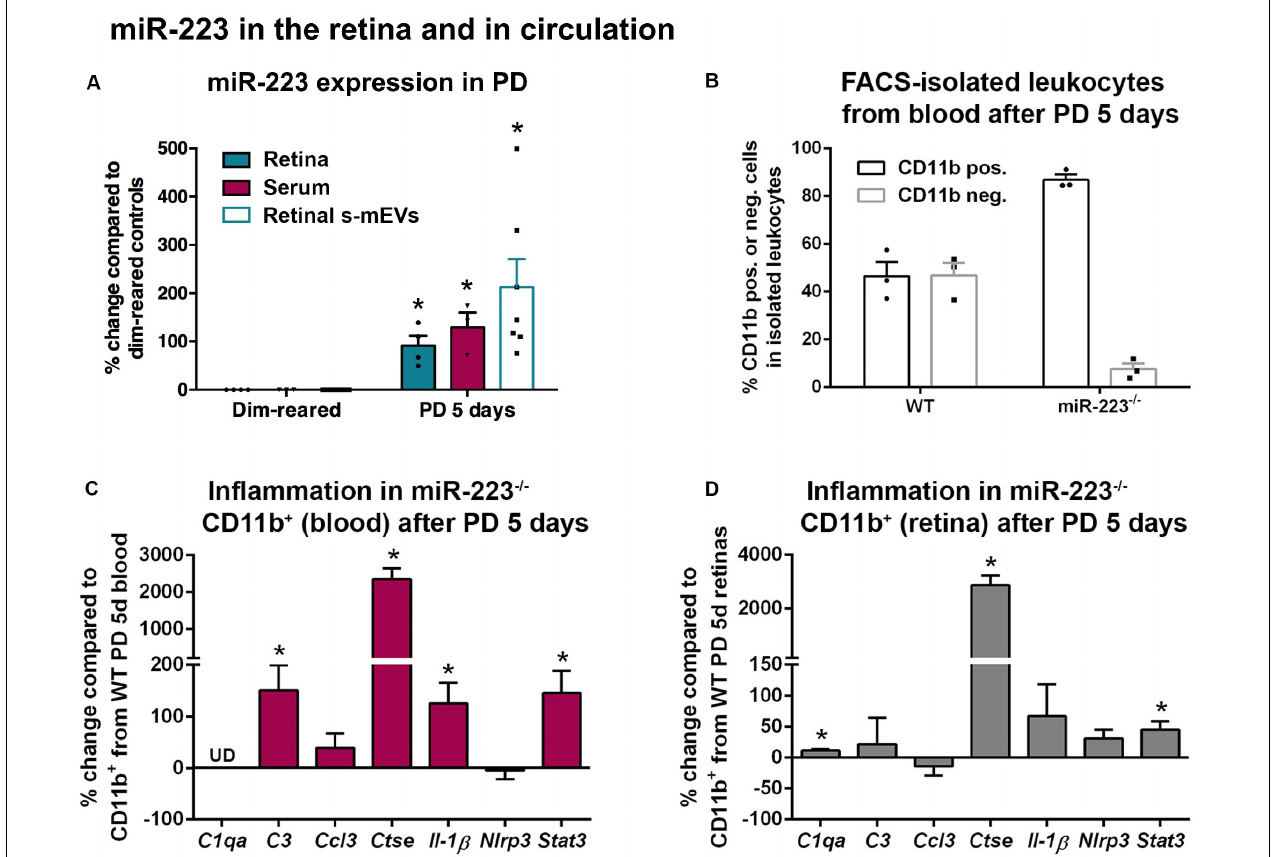
FIGURE 4 | miR-223 in the retina and circulation during retinal degeneration. (A) miR-223 was shown to be significantly increased in the retina, serum, and retinal small-medium extracellular vesicles (s-mEVs) at 5 days of photo-oxidative damage (PD), compared to dim-reared control retinas, serum, and s-mEVs, respectively ( P < 0.05). (B) During FACS-isolation of leukocytes after 5 days of PD, the number of CD11b + cells to CD11b − cells was skewed in the miR-223 − / − mouse blood compared to wild-type (WT) mouse blood, where the proportion between positive and negative populations was more even. (C) In CD11b + cells isolated from blood after PD, C3 , Ctse , Il-1 β , and Stat3 were all significantly upregulated compared to CD11b + cells from WT ( P < 0.05). The expression of C1qa was undefined (UD). (D) In the retina, CD11b + cells had a significantly higher expression of C1qa , Ctse , and Stat3 after PD compared to WT retinal CD11b + cells ( P < 0.05). Sample size is N = 3–7. *Denotes significance ( P <